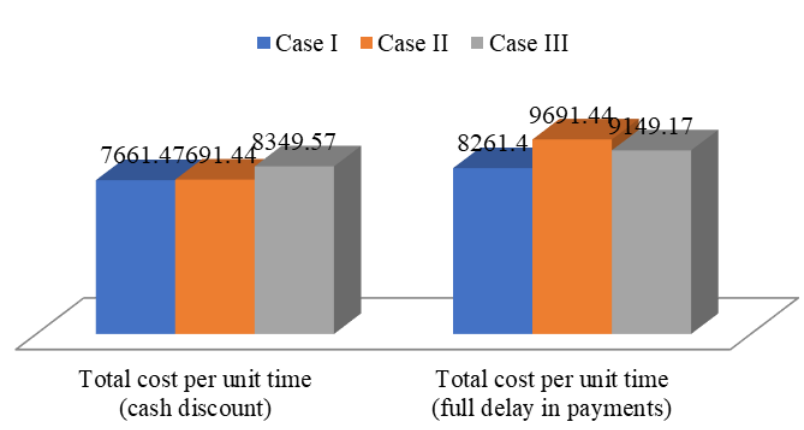
Figure 7. Minimum measures in the COVID-19 situation under the two policies. Figure 8. The percentage of trade credit balances being paid on time in each country (Source: S&P Global Market Intelligence, 5 June 2020. For illustrative purposes